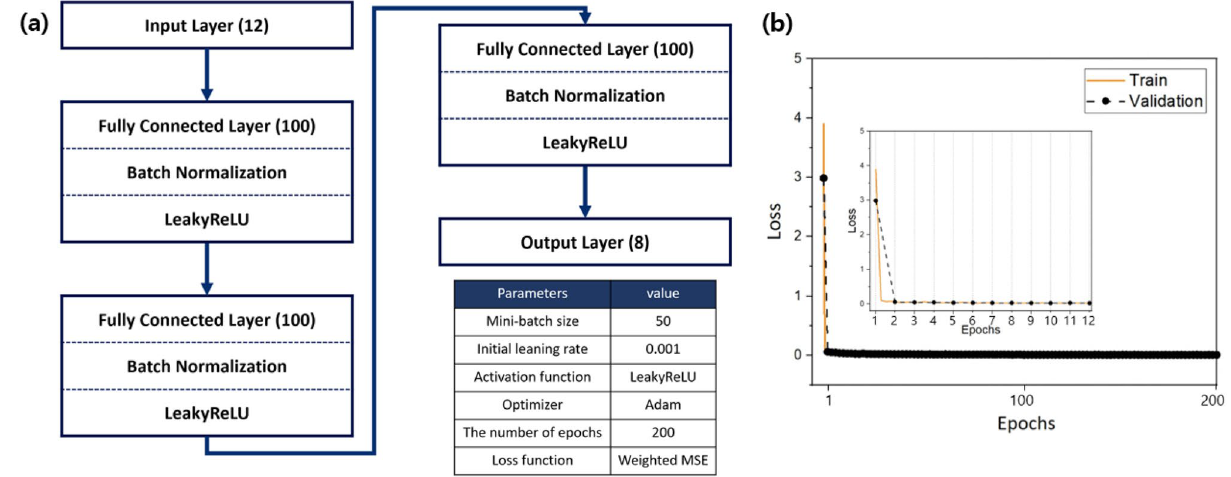
Figure 4. ( a ) Network structure and parameters of the DNN model, ( b ) curve of loss function during DNN model